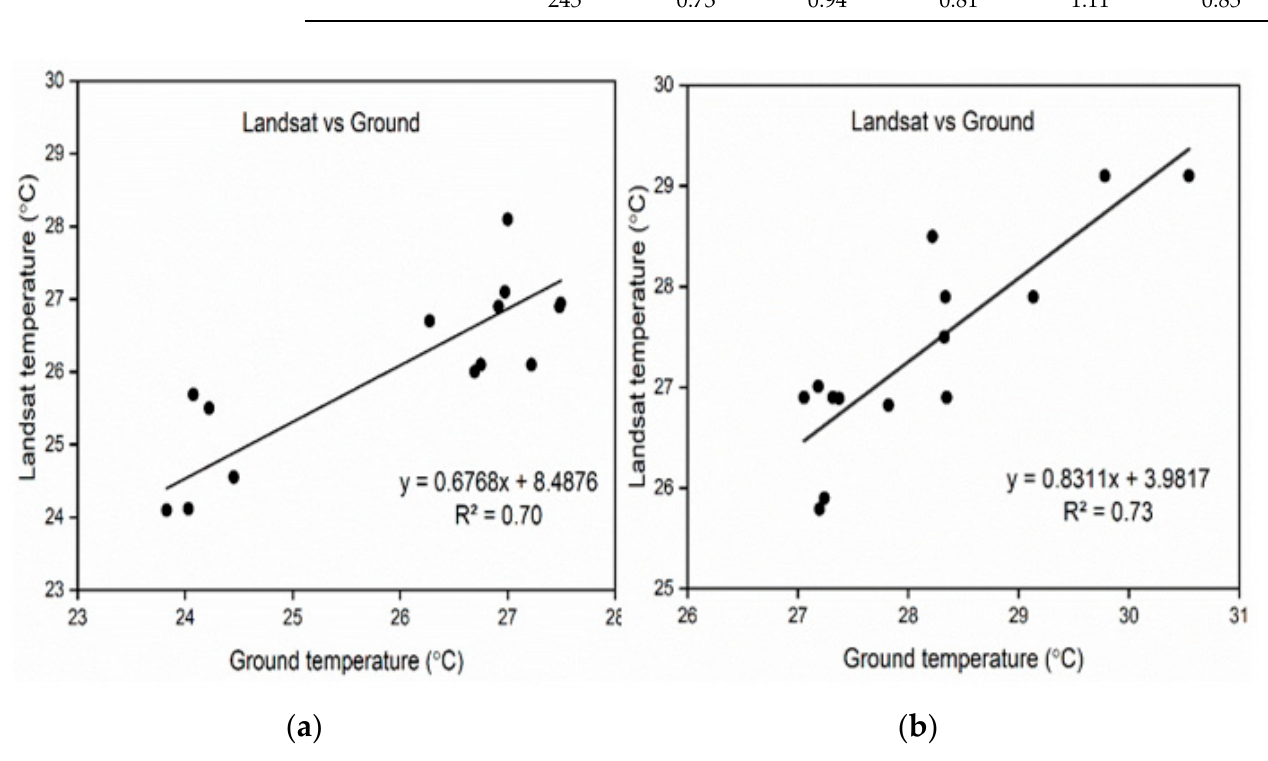
Figure 8. Relationship between Landsat 8-TIR sensor and ground measurements, ( a ) DOY 230, ( b ) DOY